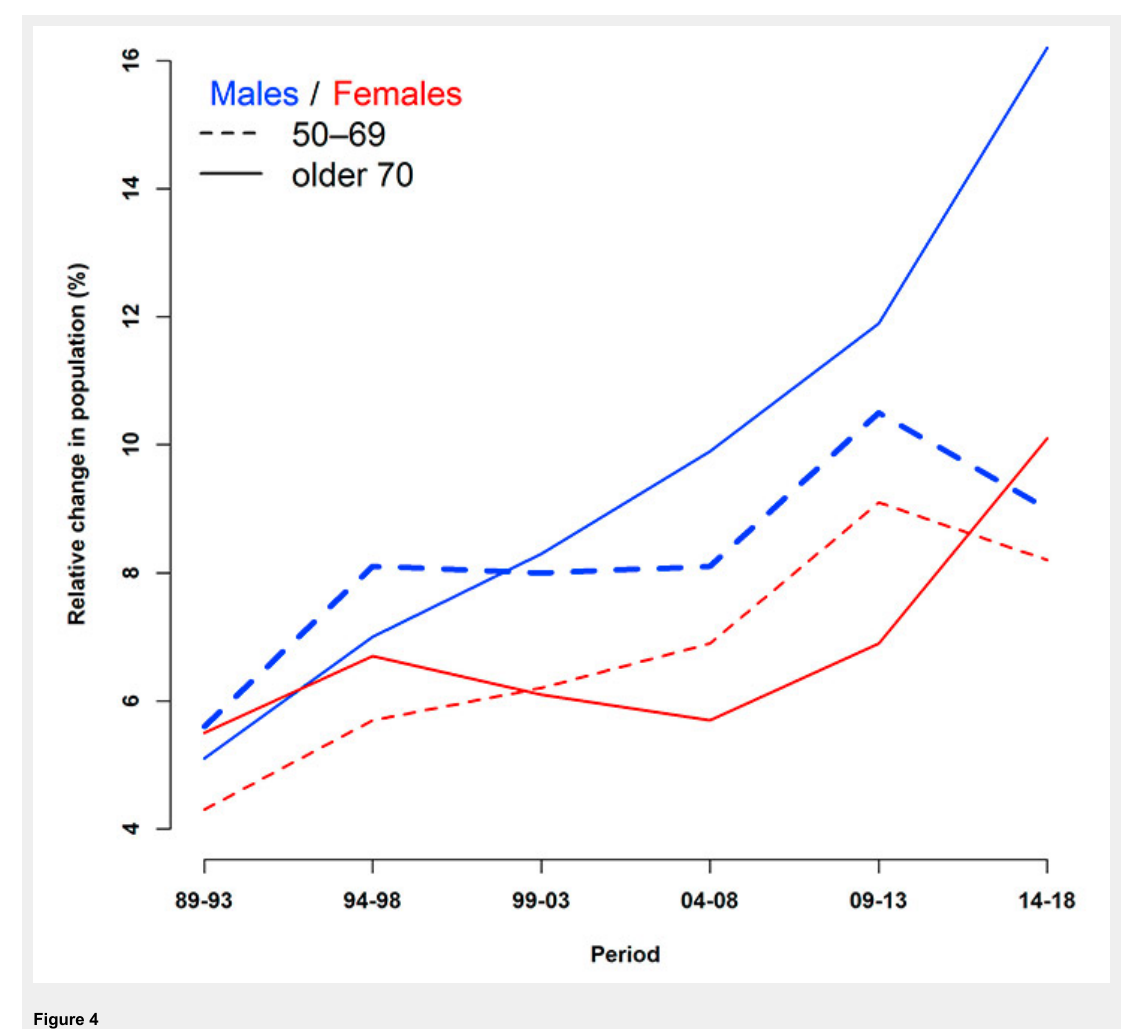
Figure 4 Relative change in population (in % based on preceding year) for males (red) and females (blue) and age groups 50–69 (dashed) and ≥70